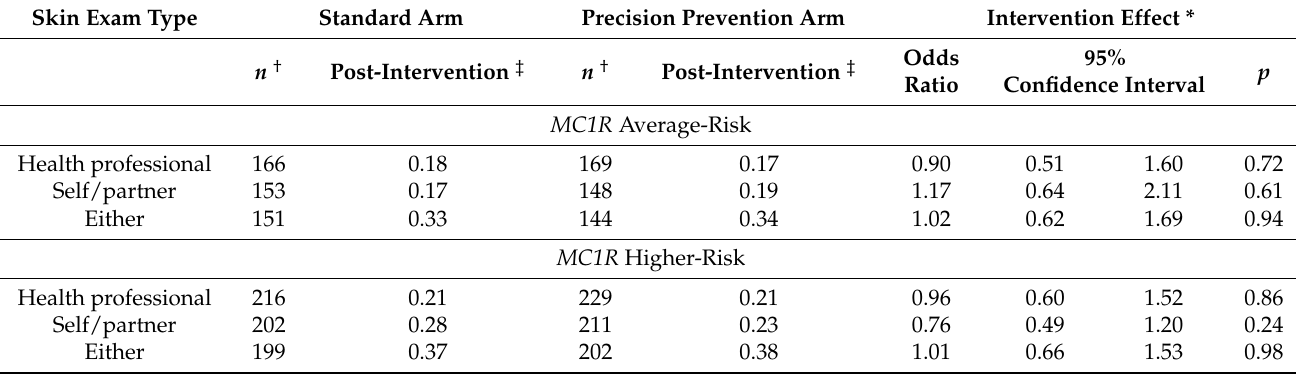
Table 3. Secondary prevention outcomes at post-intervention and intervention effects by MC1R risk category.